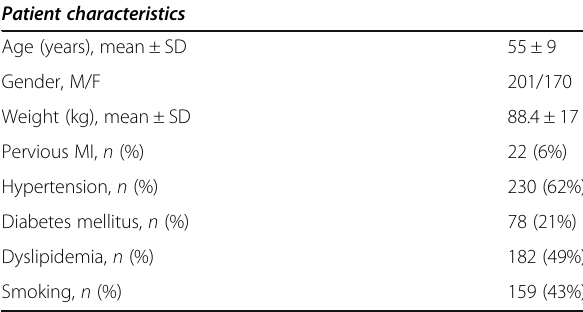
Table 2 Patients ’ characteristics of all subjects who underwent both CMR and MSCT scans Patient characteristics